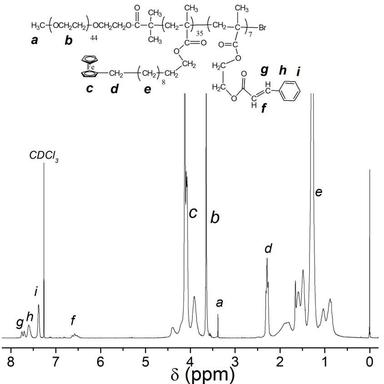
1 H NMR spectrum of PEO-PFc-PCA in CDCl3 at room temperature.